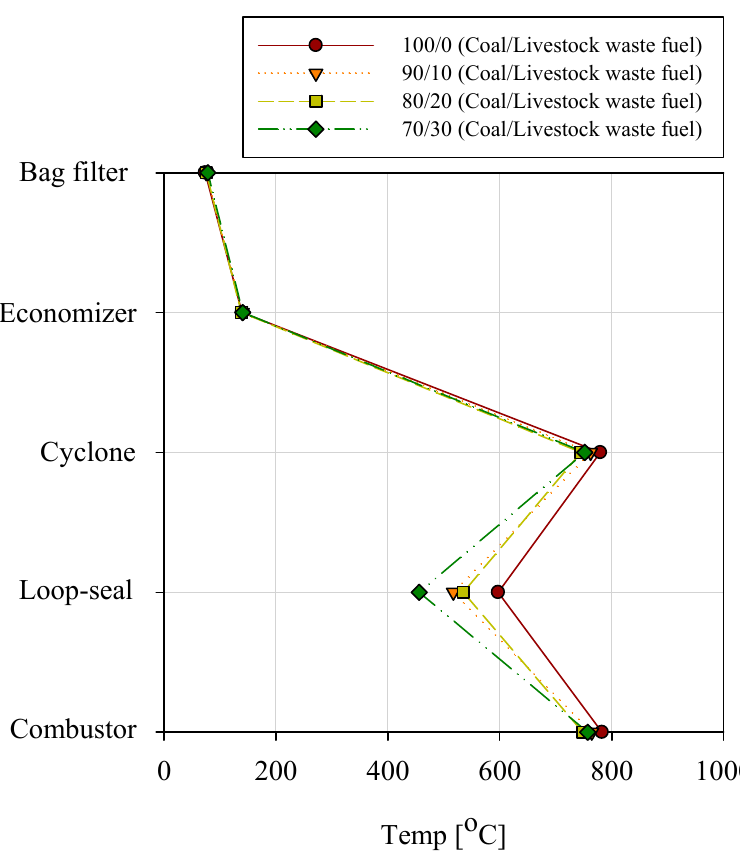
Figure 4. Combustion characteristic of livestock waste fuel at CFBC boiler.